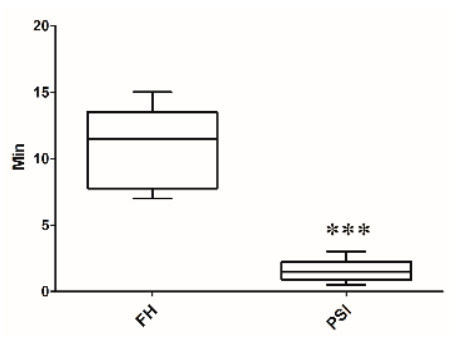
Figure 13. Boxplot displaying the time consumption for the cutting procedure after applying the two different methods: freehand (FH) versus patient ‐ specific instrumentation (PSI). *** p < 0.001, t ‐ test vs. FH.